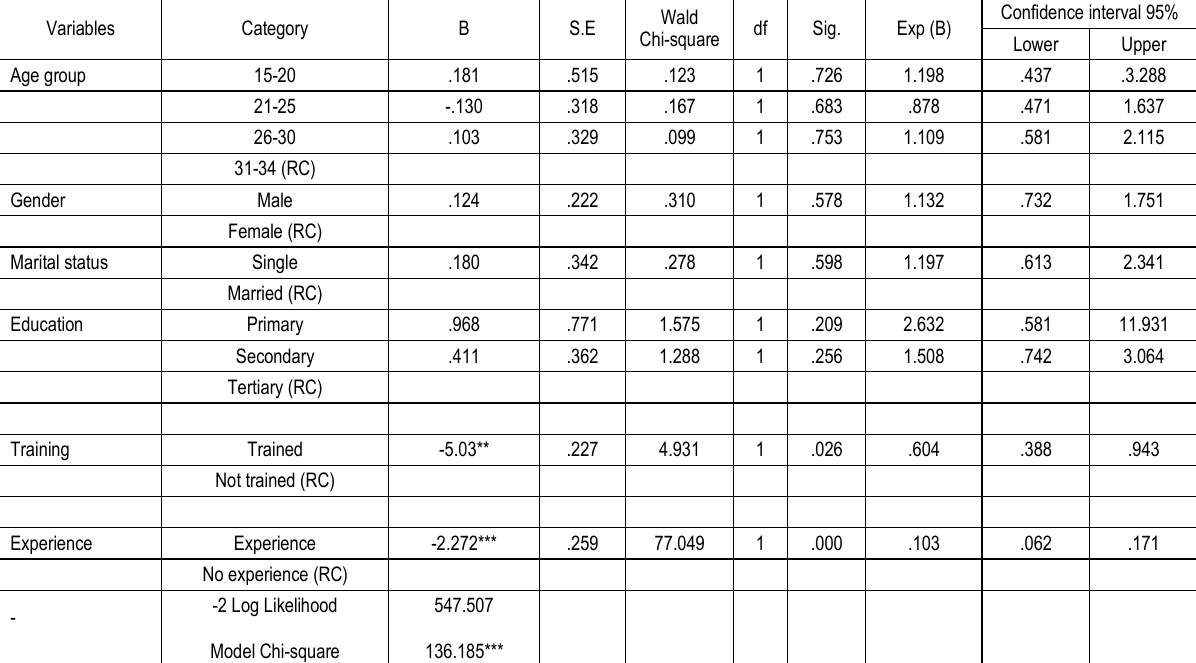
Table 1. Parameter estimates of the logistic model of the determinants of youth unemployment